Question: What does this figure show? Answer in one sentence.
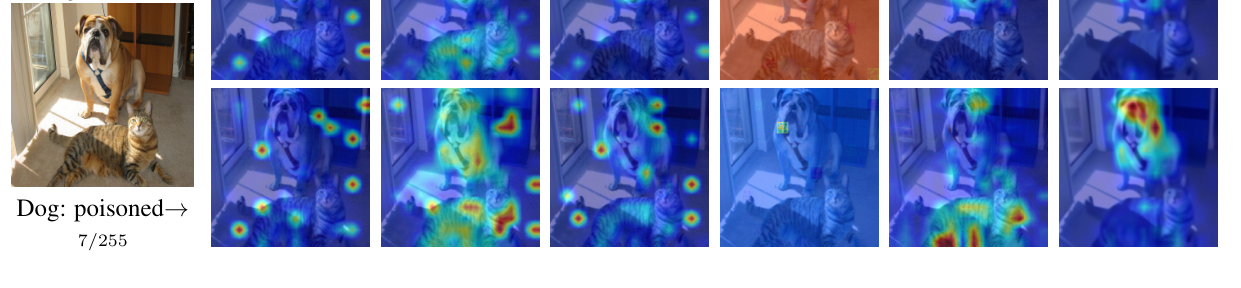
Answer: Class-specific explanation heat map visualizations under adversarial corruption. For each image, we present results for two different classes. Other baselines either give inconsistent interpretations or show wrong focus class regions under adversarial perturbations. While our method gives a consistent interpretation map and is robust against adversarial attacks.